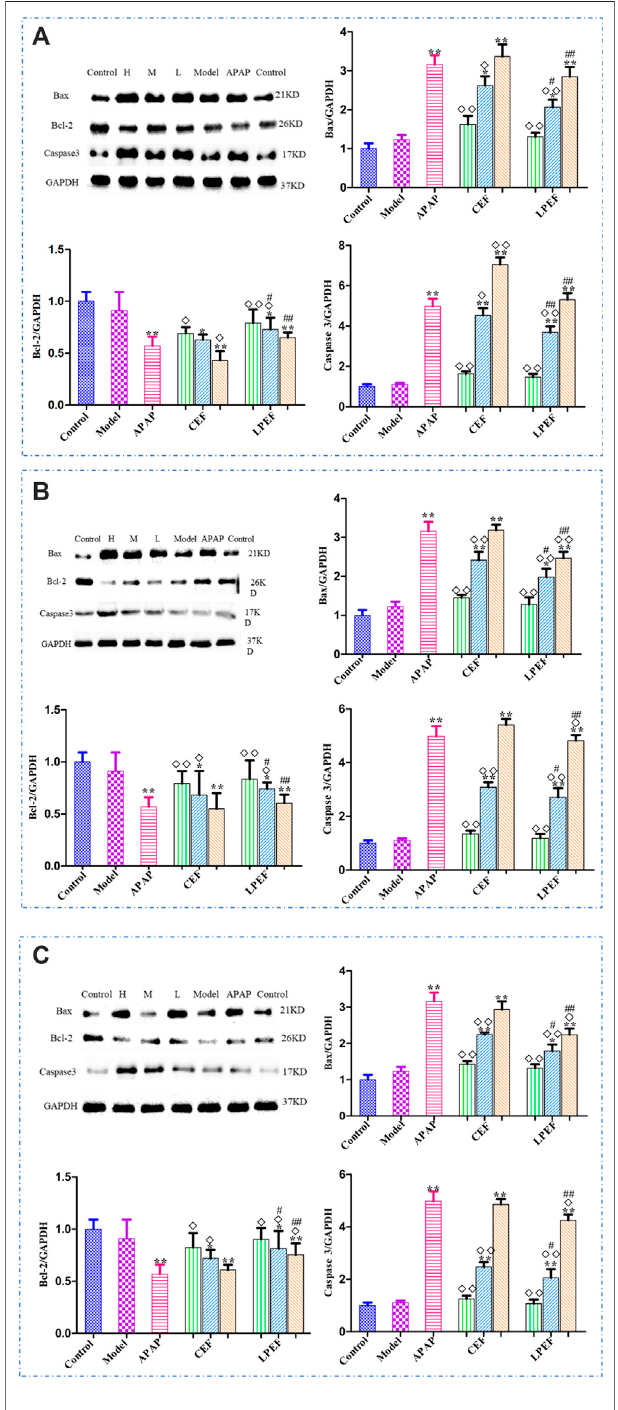
FIGURE 8 | Effects of different drugs on apoptosis-associated proteins in rats with stomach excess-cold syndrome: WE (A) , EE (B) , and VO (C) . Values are mean ± SD of three replicated sample; vs. control group, p < 0.05 ( * ) and p < 0.01 ( ** );vs. CEF, p < 0.05 ( # ) and p < 0.01 ( ## );vs. APAP, p < 0.05 ( ◇ ) and p < 0.01 ( ◇◇ ). 10.5 g kg − 1 , 5.25 g kg − 1 , 1.05 g kg − 1